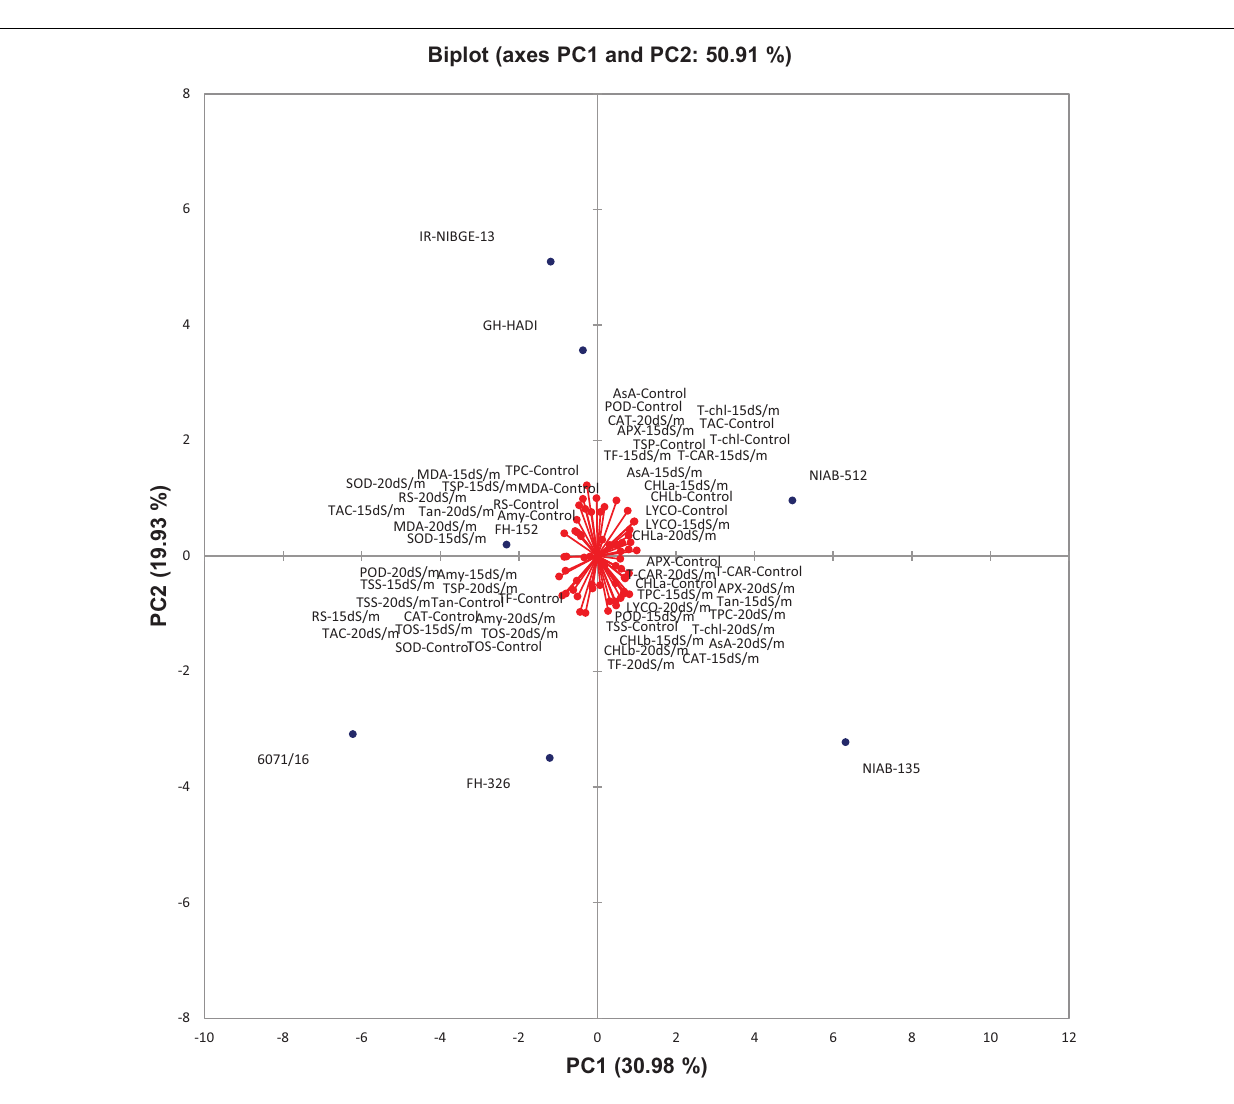
FIGURE 16 | Biplot illustration of all the genotypes under control and salt stress